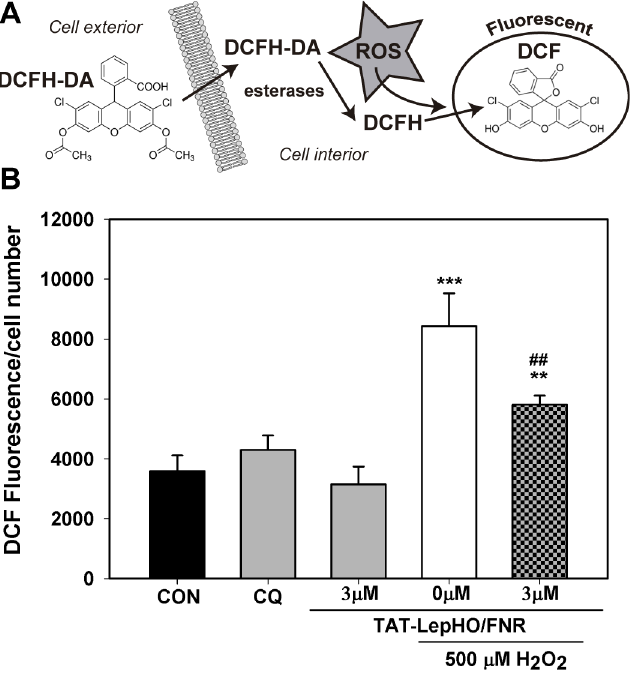
Fig 10. Intracellular ROS decreasemediated by TAT-fused protein delivery. (A) Strategy for reactive oxygen species quantification using DCFH-DA probe. (B) Cell monolayers were pre-treatedfor 2 h with 500 μ M H 2 O 2 . Medium was discardedand cells were loadedwith 80 μ M DCFH-DA (30 min) and washed. Cells were either incubatedin serum free medium alone or treated with 3 μ M TAT fused proteinsand 100 μ M Chloroquine (1 h). CQ representsa control where DCFH-DA loadedcells were subsequently incubatedwith 100 μ M chloroquinealone. After trypsinization, cells were resuspended in PBS buffer and transferred to a black 96 well plate to read fluorescence at 520 nm (excitation: 485 nm). n = 3. ** p < 0.01vs. CON (control) cells; *** p < 0.001vs. CON (control) cells; ## p < 0.01vs. H 2 O 2 alone treated cells.